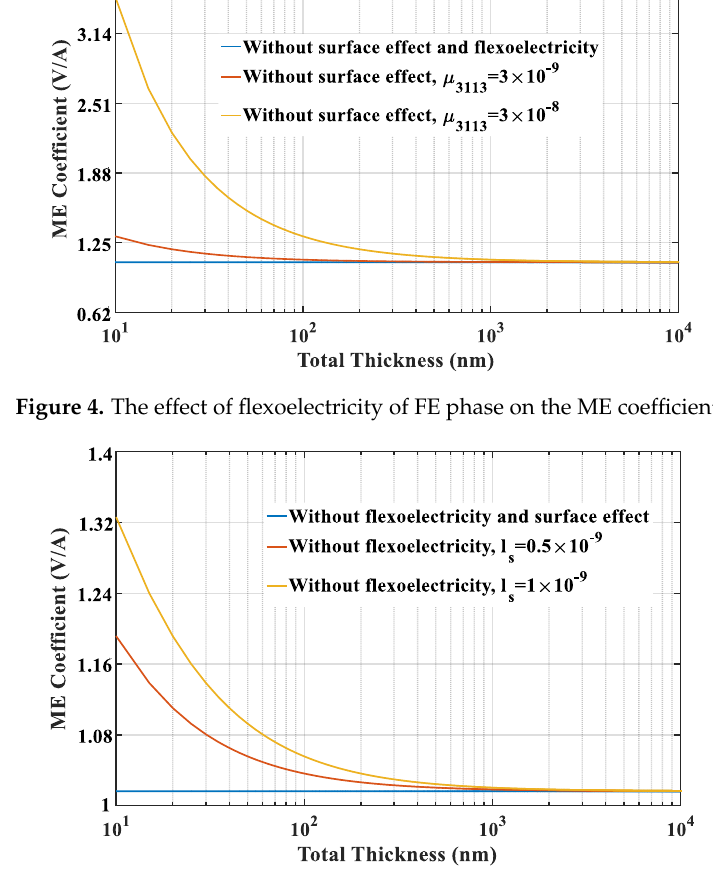
Figure 5. The effect of surface layer of FM phase on the ME coefficient.